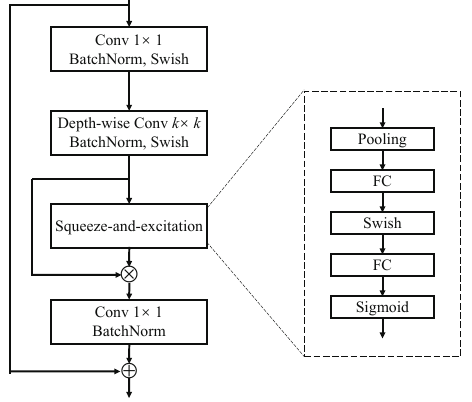
Figure 1. The structure of mobile inverted bottleneck